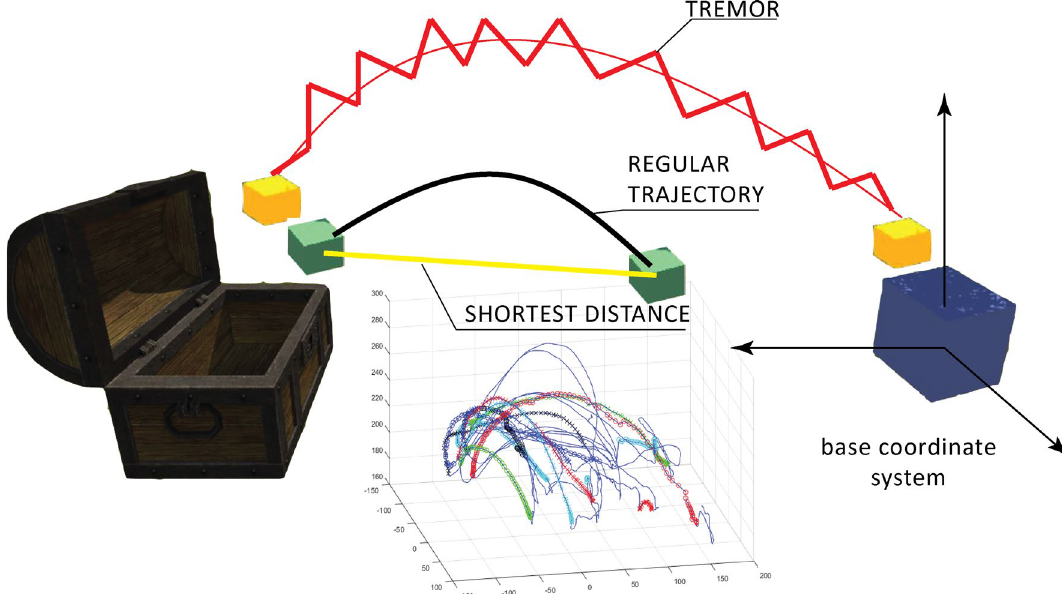
Figure 3. Tracking of the hand/palm with LMC provided trajectories in the base coordinate system that allowed calculation of the shortest distance, AToM, TNoT, and effective time of the exergame TfFTtE. The average tremor indicator (ATI) was determined from the jagged